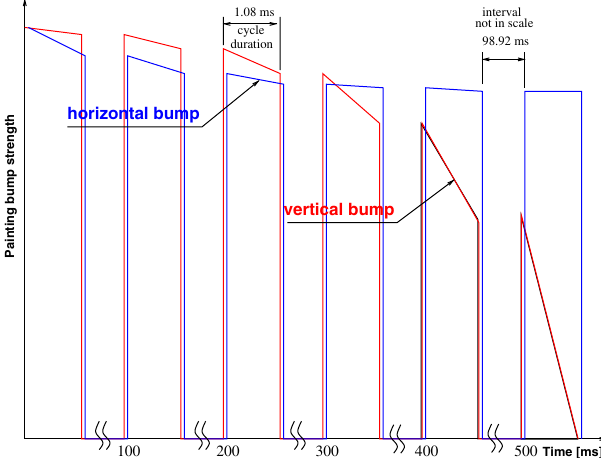
FIG. 4. Horizontal and vertical painting bump functions during injection.